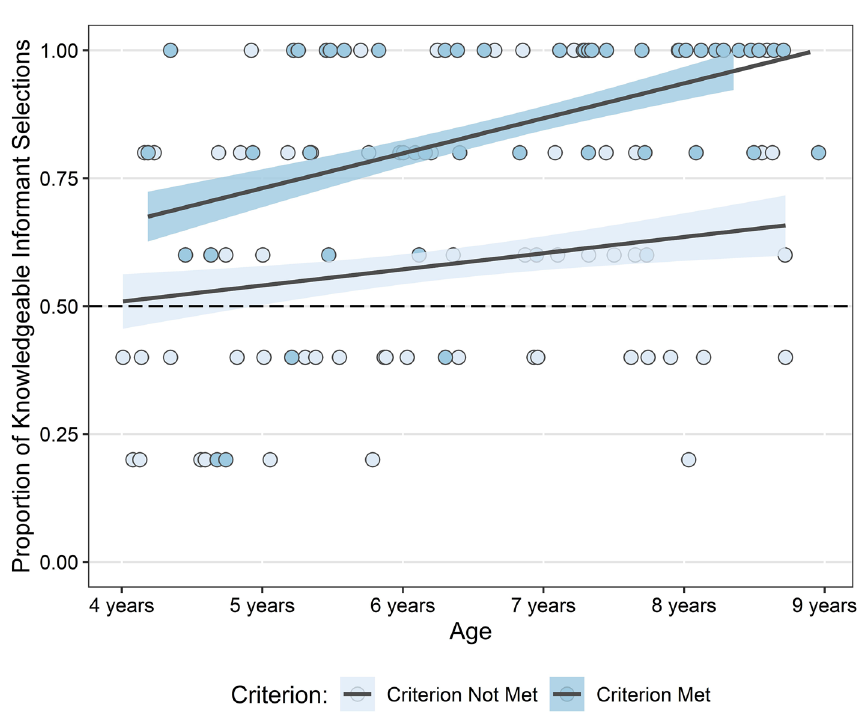
Figure 2. Proportion of knowledgeable informant selections in the switch trials by age and whether children met criterion or not. Age is plotted by age in days. Dashed line indicates chance